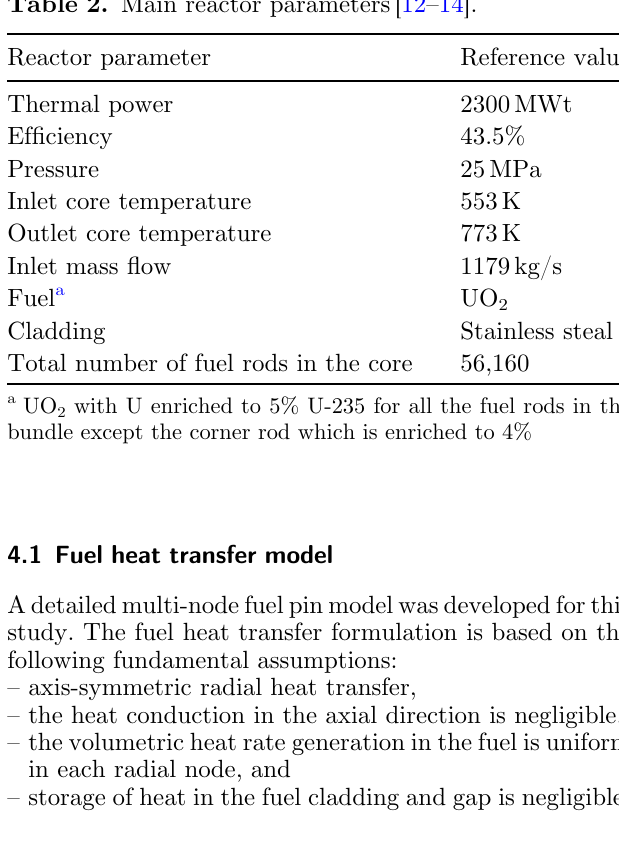
Table 2. Main reactor parameters [12 –